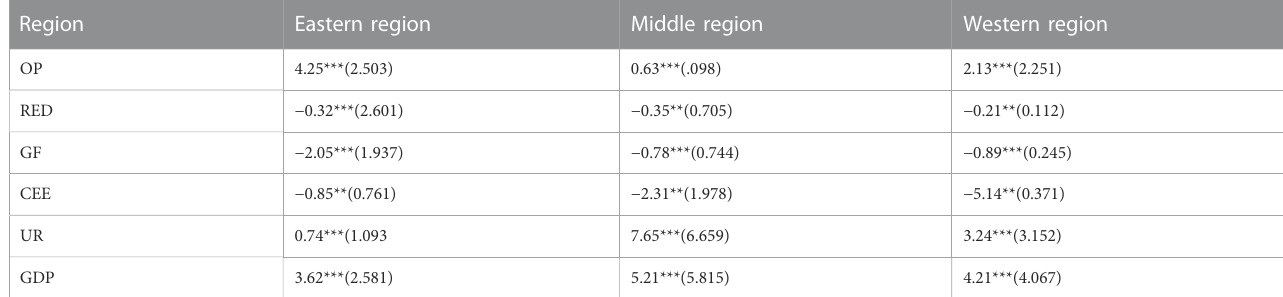
TABLE 9 Results of AGM